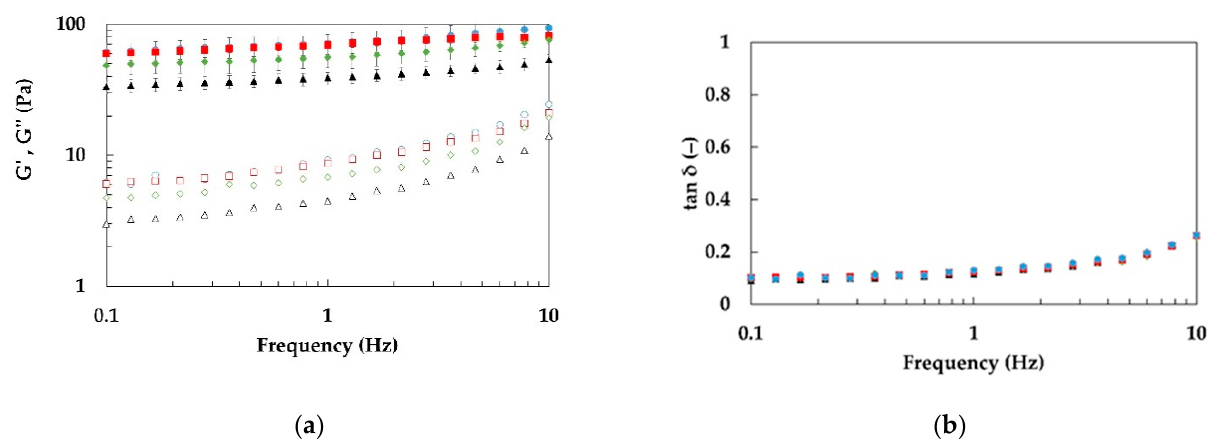
Figure 3 : Frequency sweep tests of emulgels (1% w/w dietary fiber, 20% w/w oil phase) at different specific mixing powers and at specific energy E2 s = 45.2 J/g. ( a ) Storage modulus ( G ′ , solid symbols) and loss modulus ( G ″ , open symbols); ( b ) loss tangent (tan δ , solid symbols). E2.1.1.20: black triangles, E2.2.1.20: green diamonds, E2.3.1.20: red squares, E2.4.1.20: blue circles.